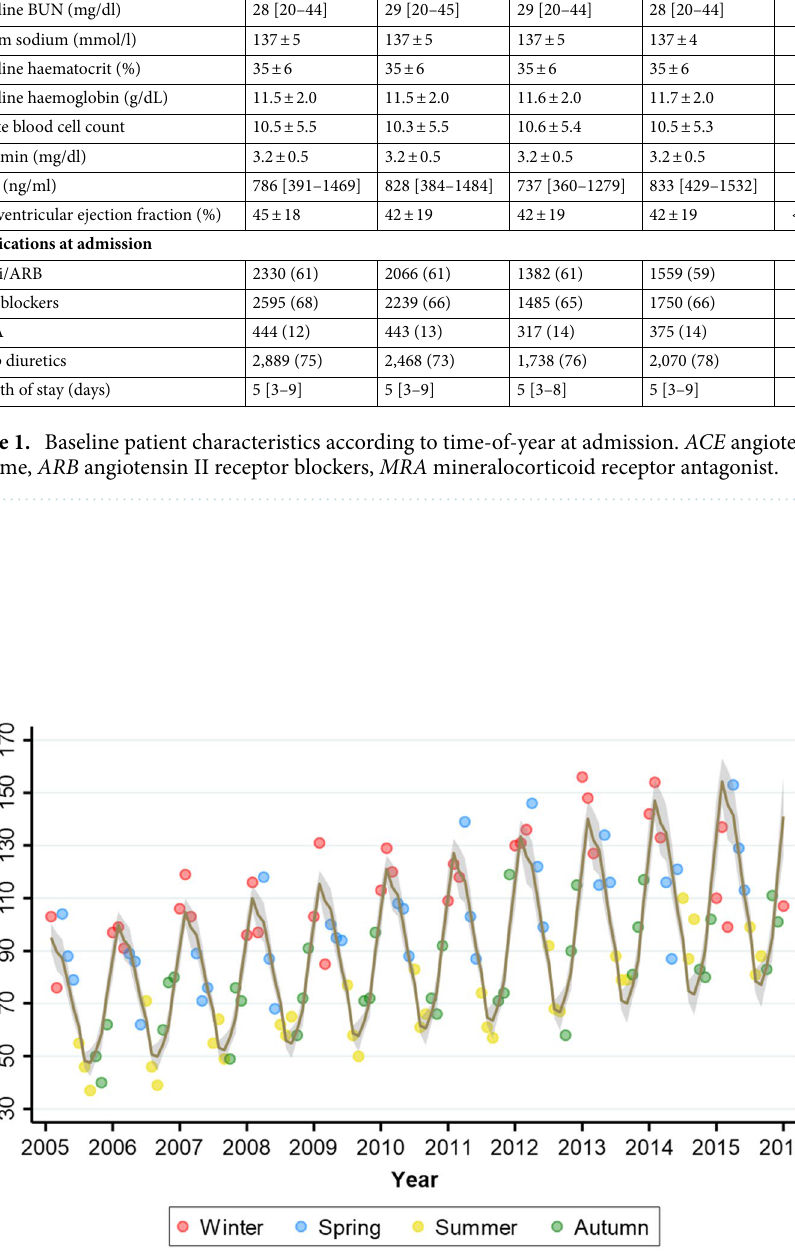
Figure 1. Crude monthly admission numbers from 2005 to 2011. The superimposed curve represents the predicted admissions (with 95% confidence interval) based on a truncated negative binomial regression